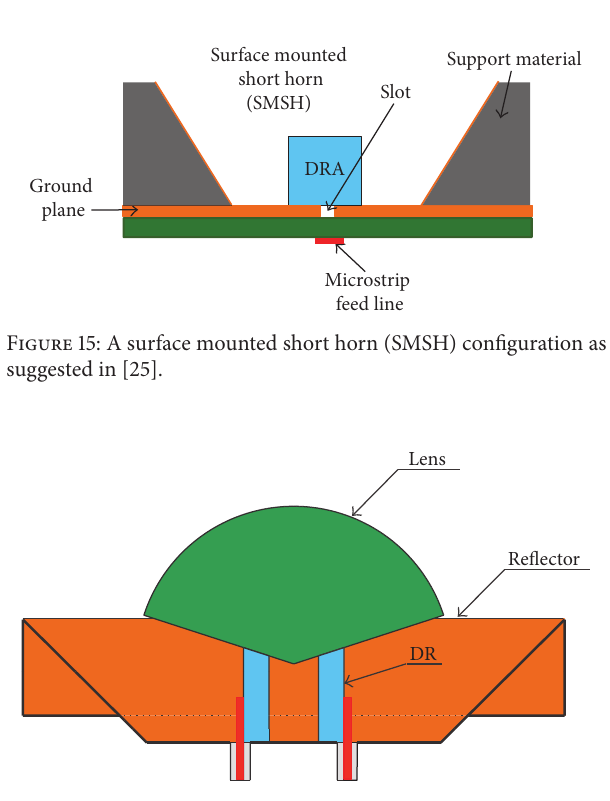
Figure 16: High-gain mushroom-shaped DRA structure as pre- sented in